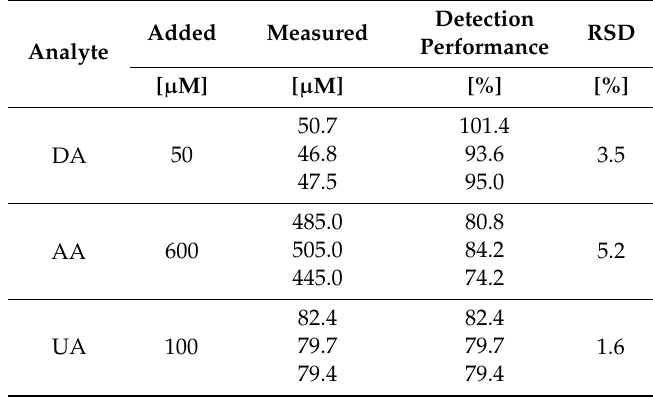
Table 4. Selectivity studies in the presence of glucose and NaCl as interfering species .